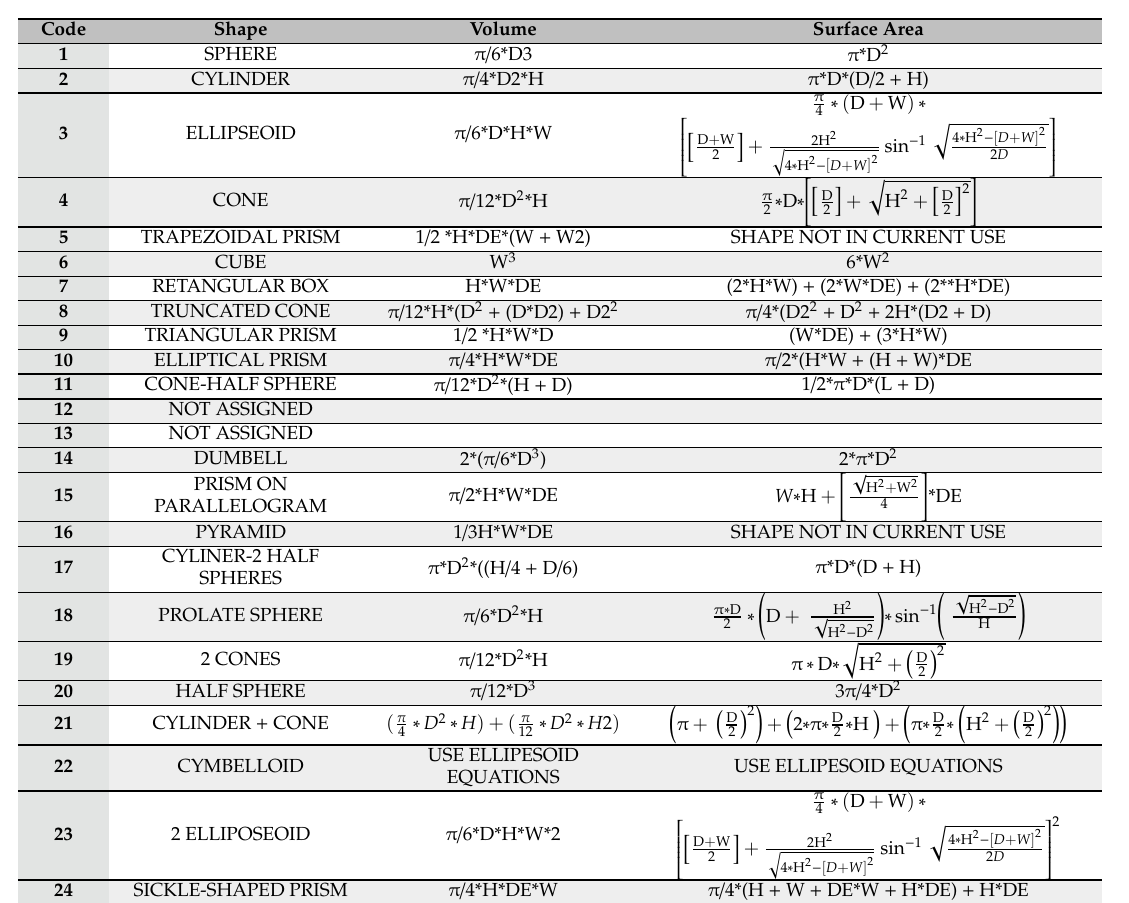
Table 2. Geometric Equations for the Estimation of Cell Volumes and Surface